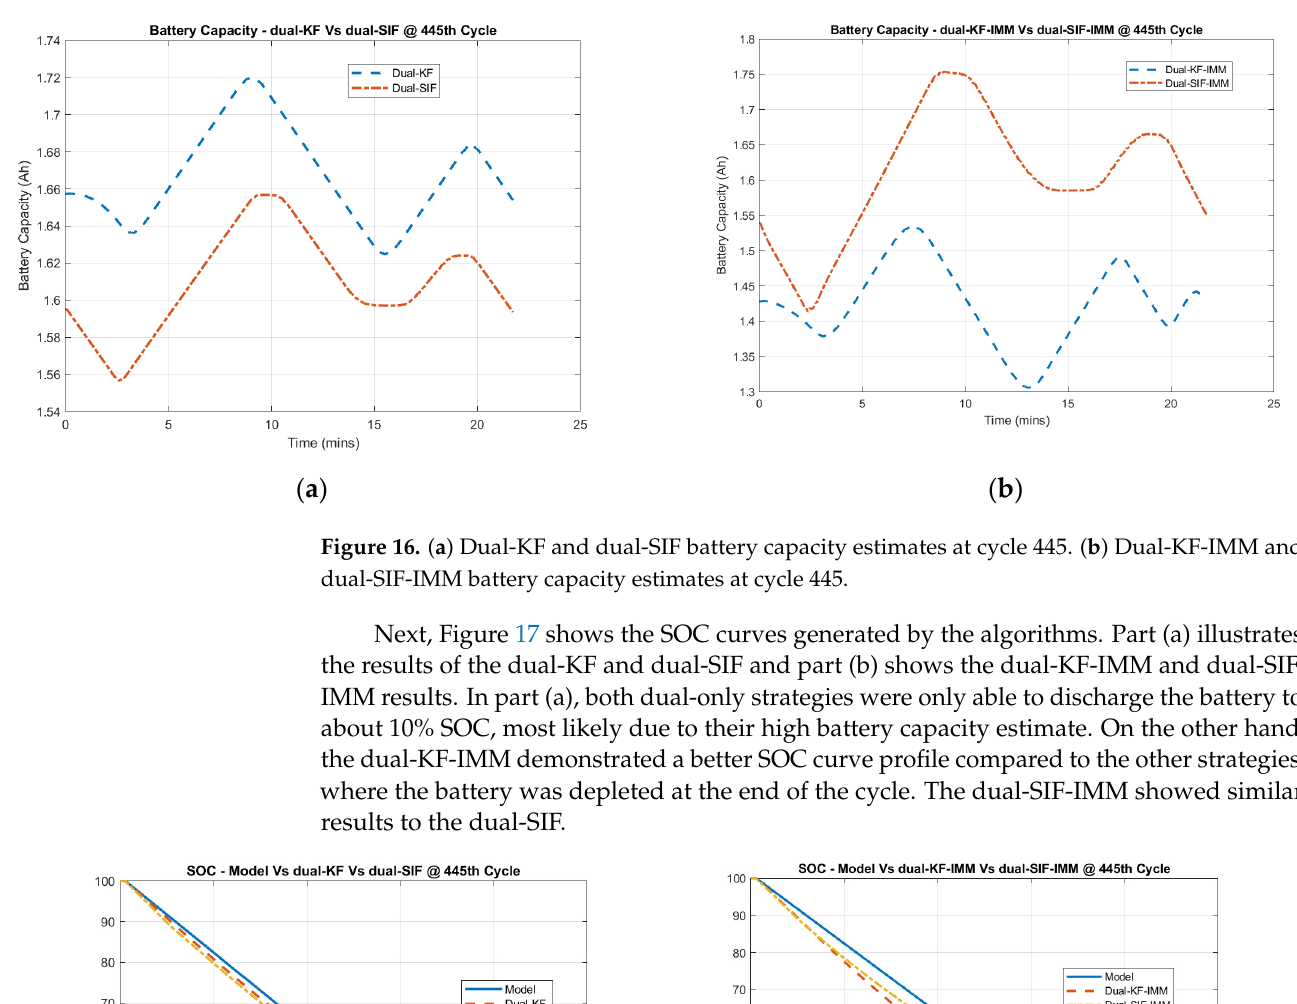
Figure 17. ( a ) Dual-KF and dual-SIF SOC estimates at cycle 445. ( b ) Dual-KF-IMM and dual-SIF- IMM SOC estimates at cycle 445.